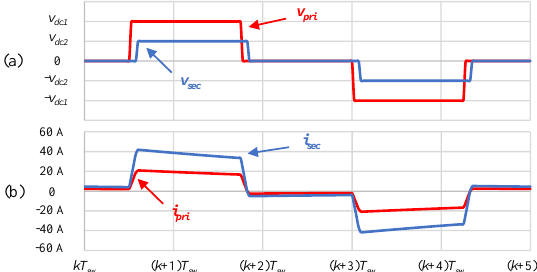
Figure 12. Waveforms in the primary and secondary sides of the HF transformer when the DAB operates under DPS modulation: (a) Voltage; (b) Current.